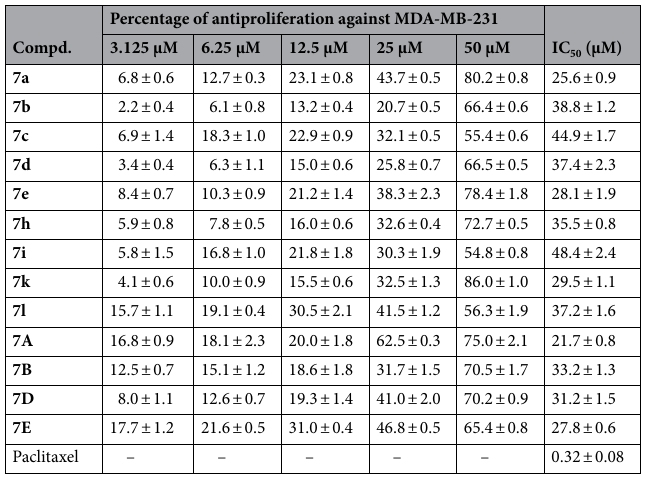
Table 2. Antiproliferative activities of selected paclitaxel-benzoxazoles hybrids against MDA-MB-231.